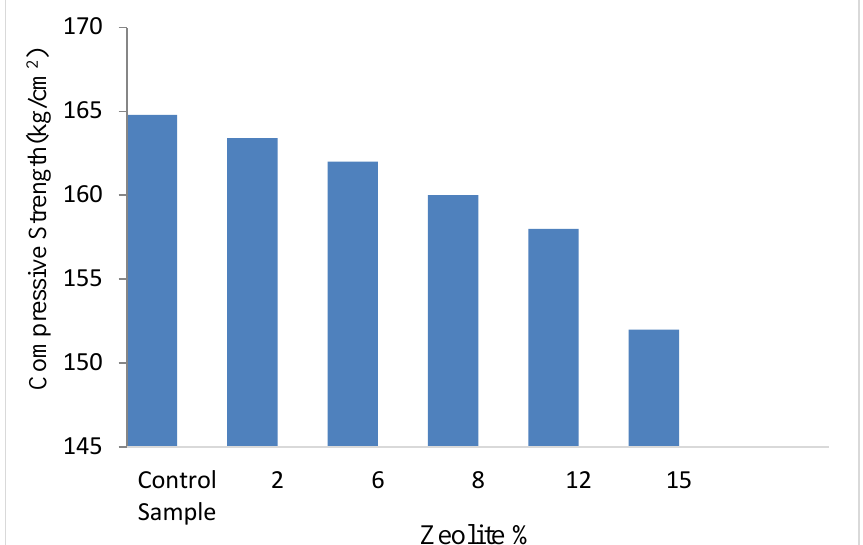
Fig. 5. Concrete strength with different percentages of Zeolite with 380 grade cement at 7 days old concrete.